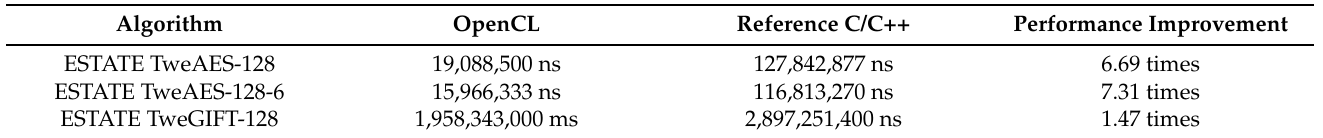
Table 8. Performance comparison of OpenCL implementation and C/C++ reference code applying the proposed method (ns: nanosecond).